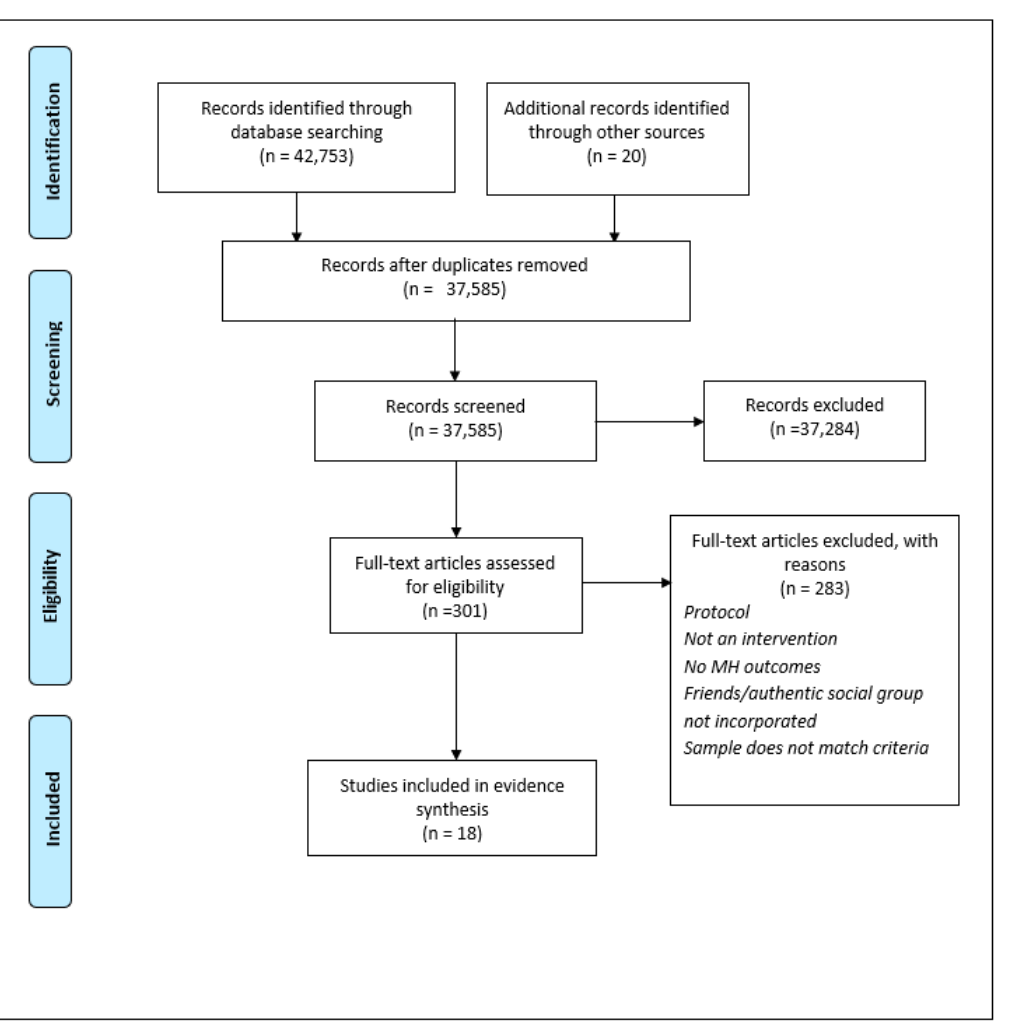
Figure 3. Flowchart depicting summary of searches and results for systematic review. From: Moher D, Liberati A, Tetzlaff J, Altman DG, The PRISMA Group (2009). P referred R eporting I tems for S ys-